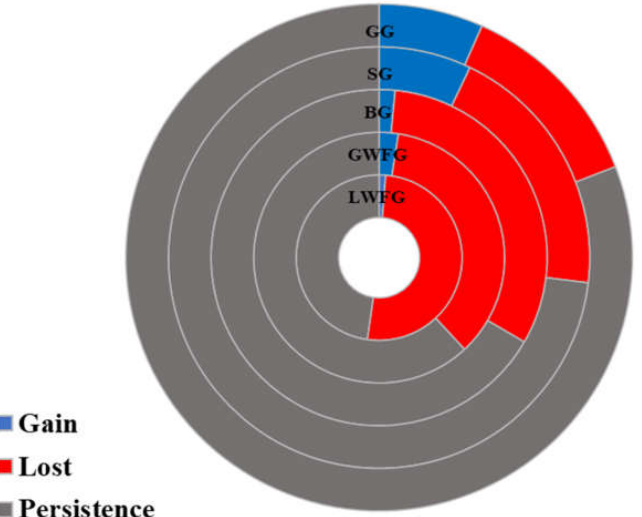
Figure 6. The suitable goose habitat loss over the past 20 years. From inside to outside, lesser white-fronted goose (LWFG); greater white-fronted goose (GWFG); bean goose (BG); swan goose (SG); greylag goose (GG).